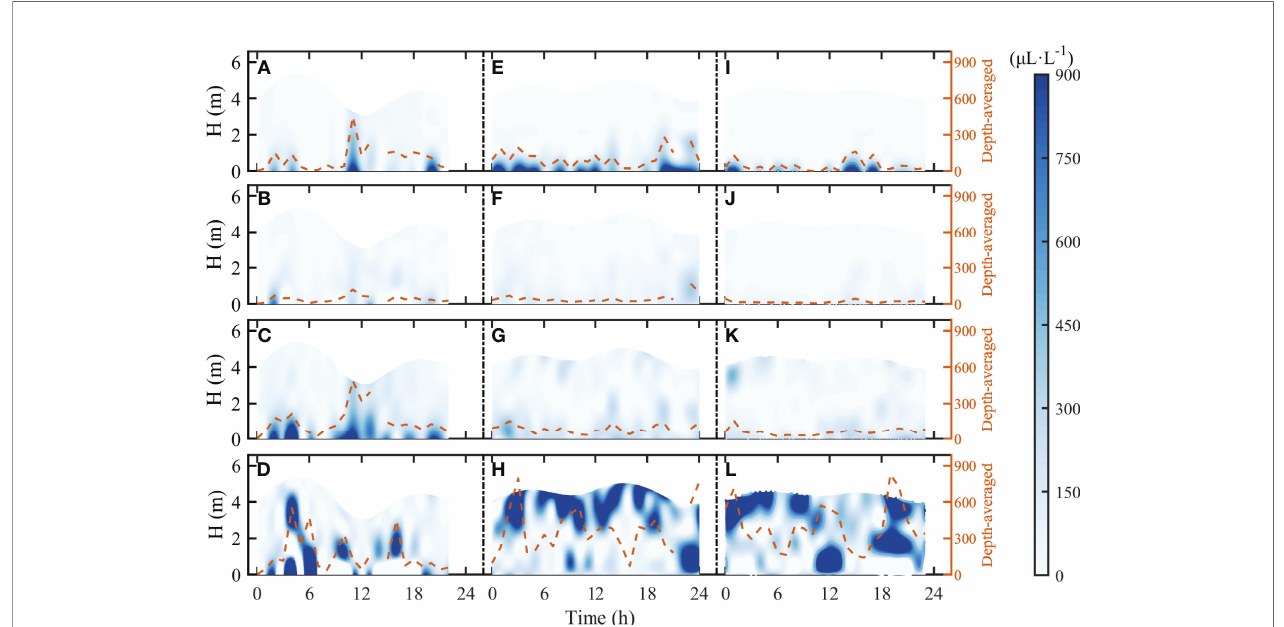
FIGURE 8 | Vertical and temporal variation of volumetric concentration of primary particles (Pp, A, E, I ), Flocculi (B, F, J) , micro fl ocs (Micro, C, G, K ), and macro fl ocs (Macro, D, H, L ). ( A – D, E – H, I – L , represent the spring, middle, and neap tides, respectively) at site M. The orange dashed lines are the temporal variations of the depth-averaged volumetric concentration ( m